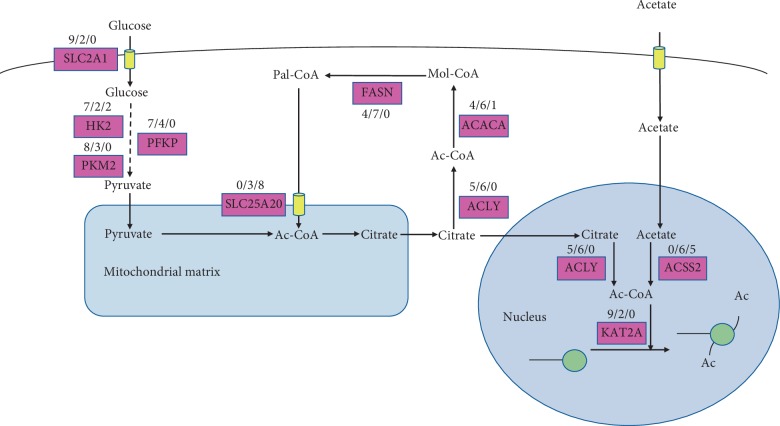
Detailed network map of transacetylation of gene expression levels in the 11 cancer types. Note: each metabolic reaction is marked with the number of tumors (out of 11 considered in our analysis) in which at least one gene in the corresponding reaction is significantly (FDR < 0.05) upregulated (red), downregulated (green), and neutral (black). If unmarked, no statistically significant change in mRNA expression was detected. Cytoplasmic citrate came from mitochondrial citrate which was produced by glucose for glycolysis in the cytoplasm and TCA cycling in the mitochondria. With the catalysis of ACLY, ACACA, and FASN, part of citrate was used to generate long-chain fatty acid which then would be oxidized in the mitochondria. Nuclear citrate and acetate were separately catalyzed by ACLY and ACSS2 to ac-CoA, which provided the acetyl groups to histones that led to histone acetylation. SLC2A1: solute carrier family 2 member 1; SLC25A20: solute carrier family 25 member 20; HK2: hexokinase 2; PKM2: pyruvate kinase M1/2; PFKP: phosphofructokinase, platelet; ACLY: ATP citrate lyase; ACACA: acetyl-CoA carboxylase alpha; FASN: fatty acid synthase; ACSS2: acyl-CoA synthetase short-chain family member 2; KAT2A: lysine acetyltransferase 2A; Ac-CoA: acetyl coenzyme A; Mol-CoA: malonyl-CoA; Pal-CoA: palmityl-CoA.